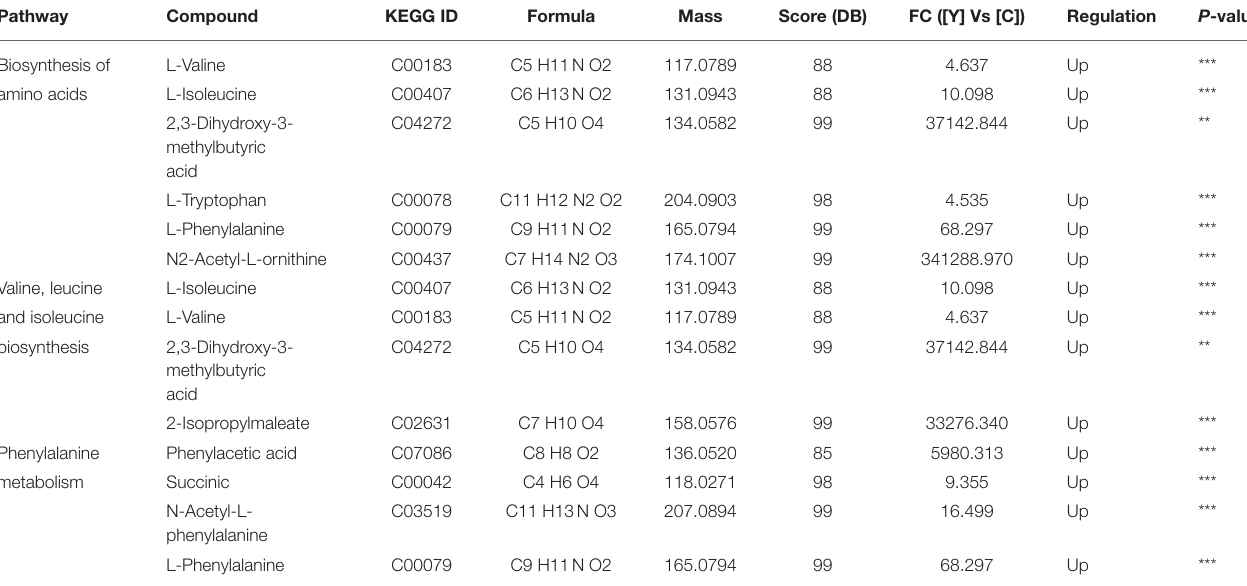
TABLE 1 | The metabolic pathway analysis base on the changed metabolites in fermented bee pollen by S. cerevisiae . Pathway